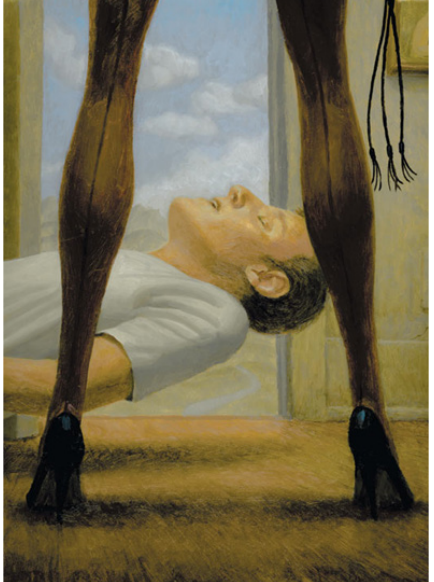
Figure 5. Y: The Last Man: Safeword Vol. 4 (2004), alternate cover by Aron Wiesenfeld. From a critical perspective of reading against the problematic sexual and racial characterisation of